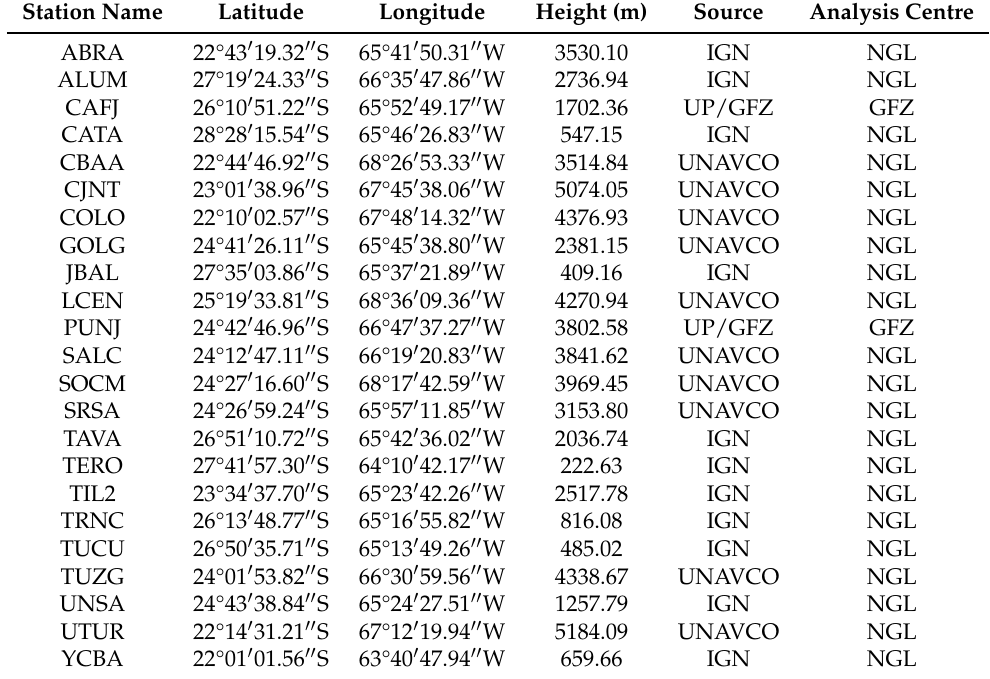
Table 1. Geographic coordinates of the stations that were used for water vapour analysis. The in- stitutions that were responsible for the installation of the facilities are listed in the column Source and are the National Geographic Institute of Argentina (Instituto Geográfico Nacional—IGN), UN- AVCO, the University of Potsdam (UP), and the German Research Centre for Geosciences (Deutsches GeoForschungsZentrum—GFZ). The column Analysis Centre shows where the data processing was carried out: either at the GFZ or the Nevada Geodetic Laboratory